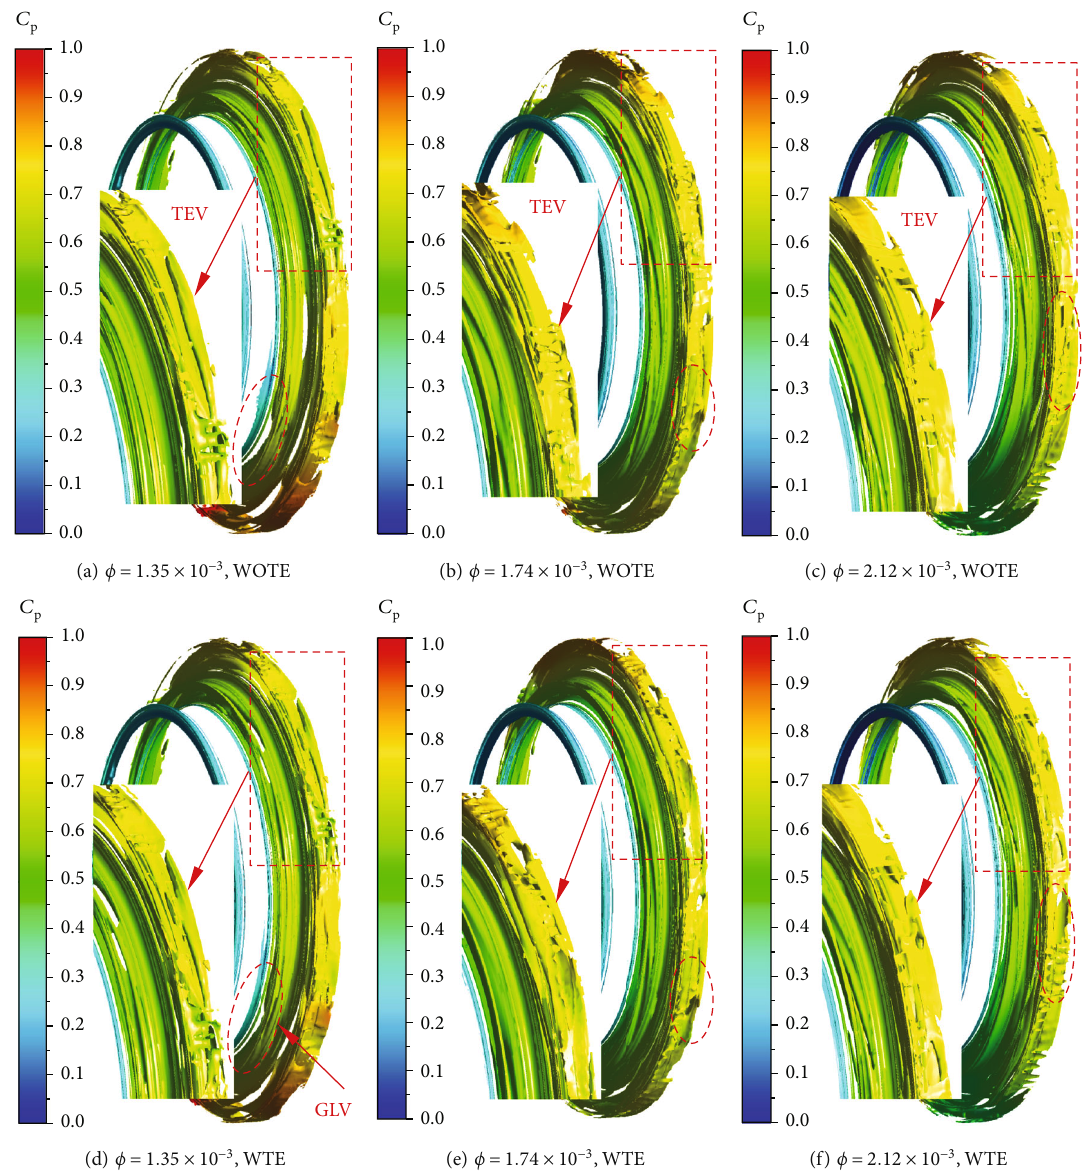
Figure 16: Comparison of the vortex with and without thermodynamic e ff